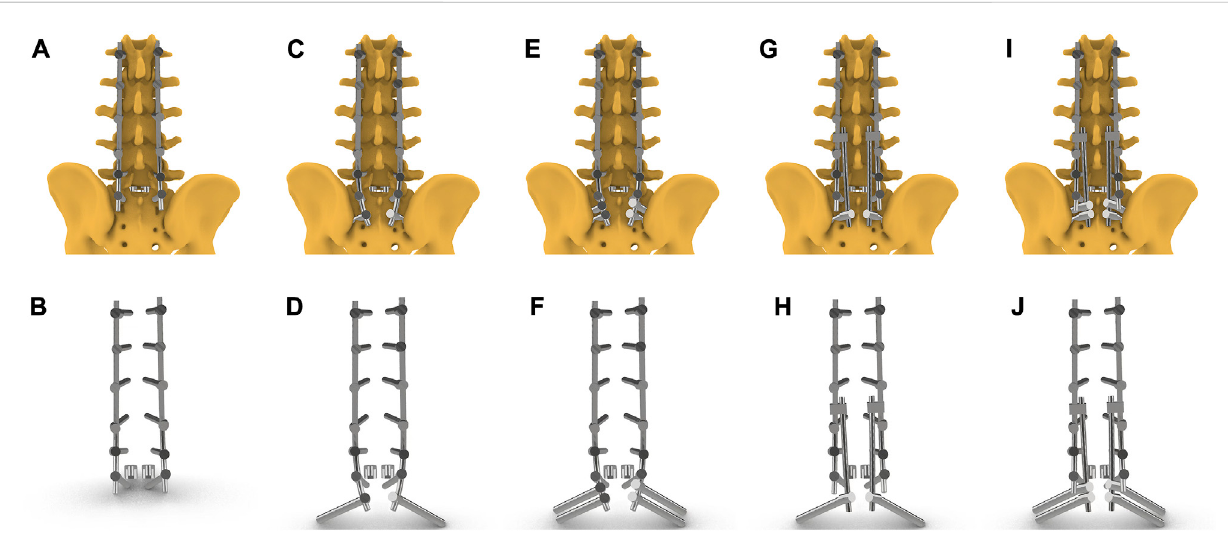
FIGURE 2 Five instrumented models including instrumentations and cages. (A, B) No-SPF: SPF was not performed and only bilateral pedicle screws were inserted at S1; (C, D) SS-SR: The primary rod was anchored to single S2AI screw, and there was no any accessory rods. (E, F) MS-SR: The primary rod was anchored to dual S2AI screws, and there was no any accessory rods; (G, H) SS-MR: The primary rod was anchored to S1-PS. Medial accessory rod was used, with distal end anchored to single S2AI screw and proximal end connected to the ipsilateral primary rod by rod-rod connector; (I, J) The primary rod was anchored to S1-PS. Medial accessory rod was used, with distal end anchored to dual S2AI screws and proximal end connected to the ipsilateral primary rod by rod-rod